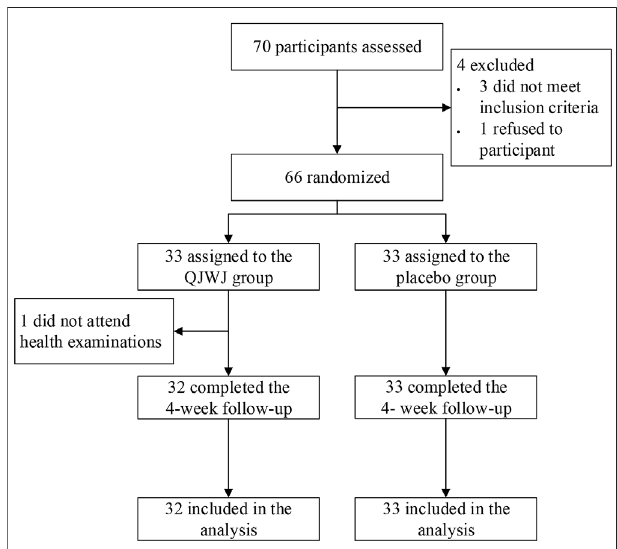
FIGURE 1 | Flow diagram of enrollment and